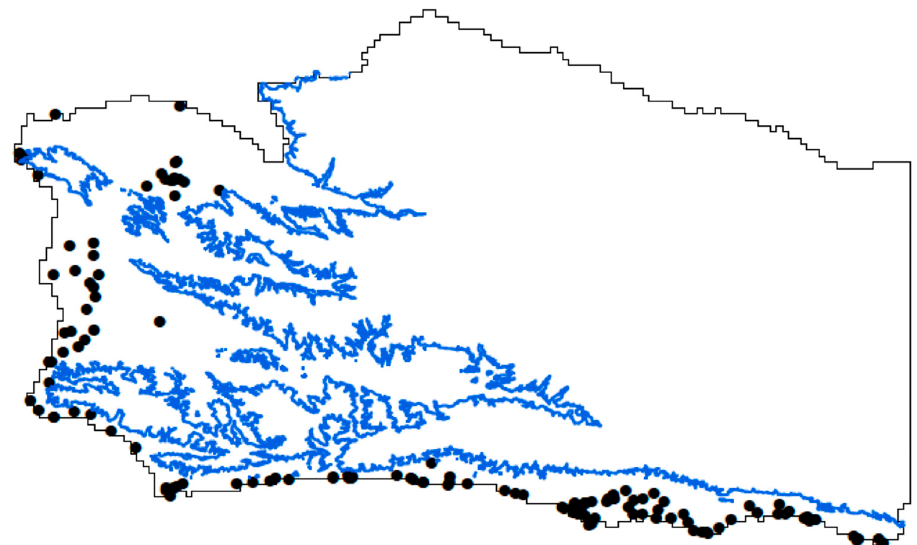
Figure 1. Santa Barbara County (black margin), 800-foot elevation contour (inscribed blue border), with approximate location of all known overwintering groves (solid black circles) in Santa Barbara County (excluding the Channel Islands).